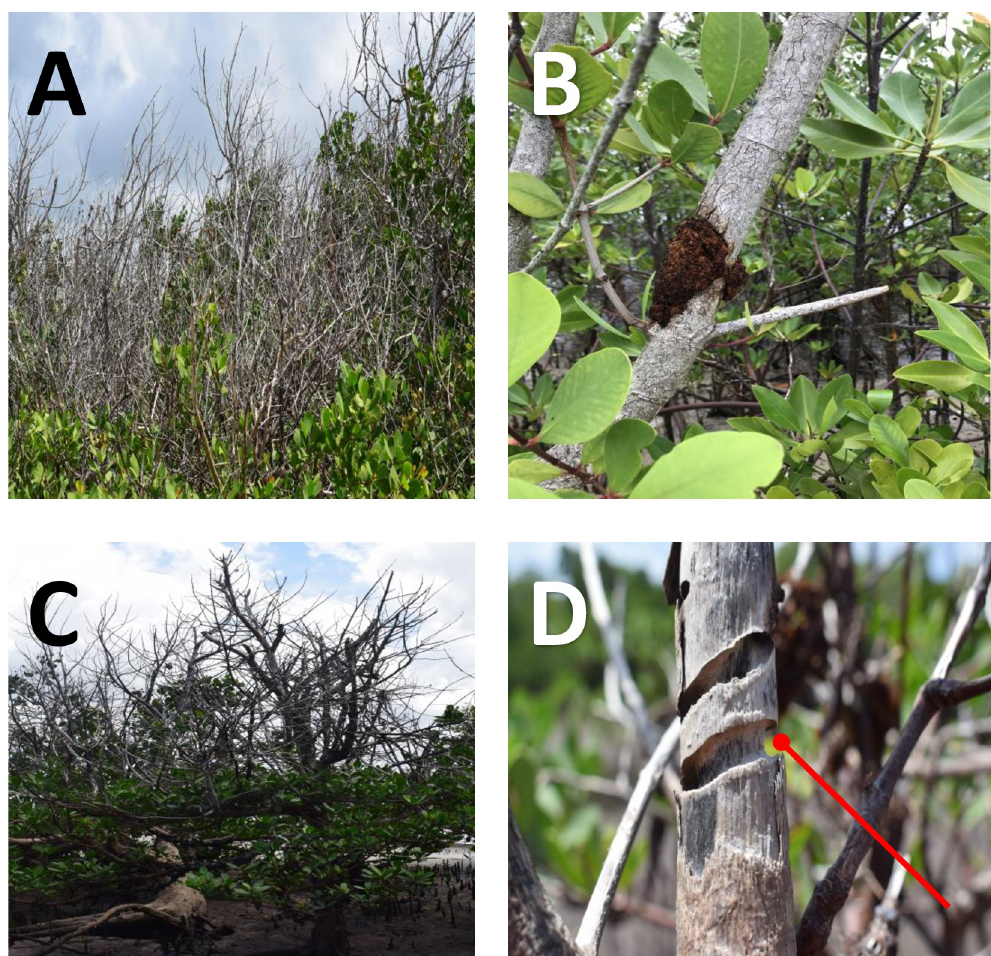
Fig 2. Infested S . alba forest in Gazi Bay and Mida Creek (C). (A) Sonneratia alba with dead infested branches in Gazi Bay, (B) a picture of a moth woodborer infested branch with frass, (C) a beetle-infested S . alba tree in Mida Creek and (D) damage done by Bottegia rubra before exiting a S . alba branch. The arrow shows the base of a branch that has been girdled by the beetle before exiting the infested branch. Apart from infestation by the metarbelid moth, the mangrove of Gazi Bay (A) has suffered from sedimentation and infestation by Agelanthus spp. a canopy plant hemiparasite, which is very common.